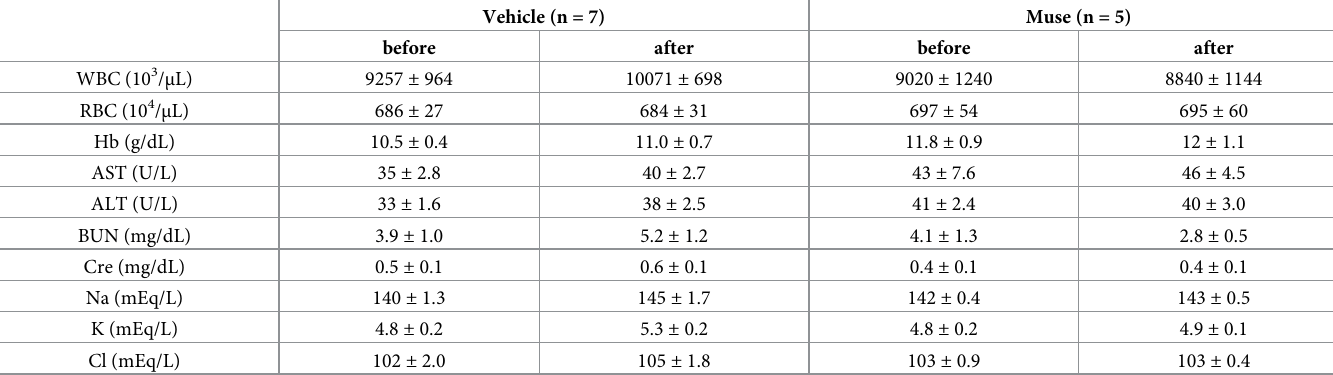
Table 1. Blood cell count and biochemical data.